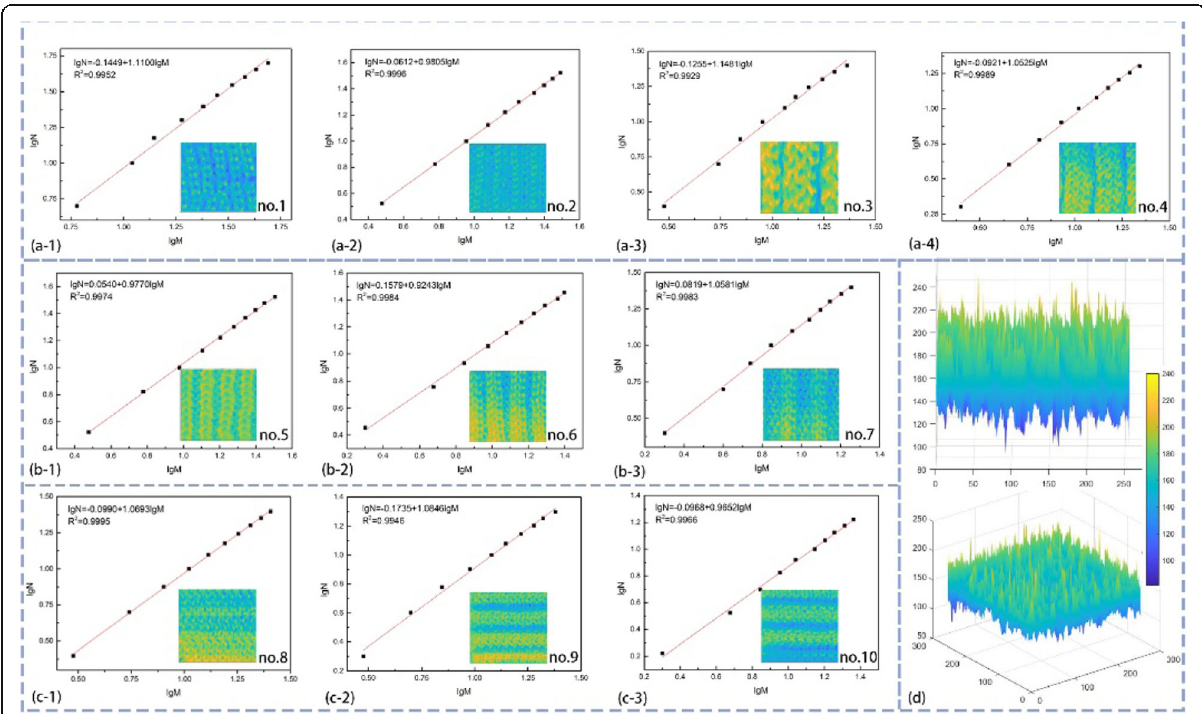
Fig. 5 Fitting curve and some visual images for knitting textiles. a The m*n rib structure. b The 2*m rib structure. c Some needle horizontal cord structure. d The visual images from different